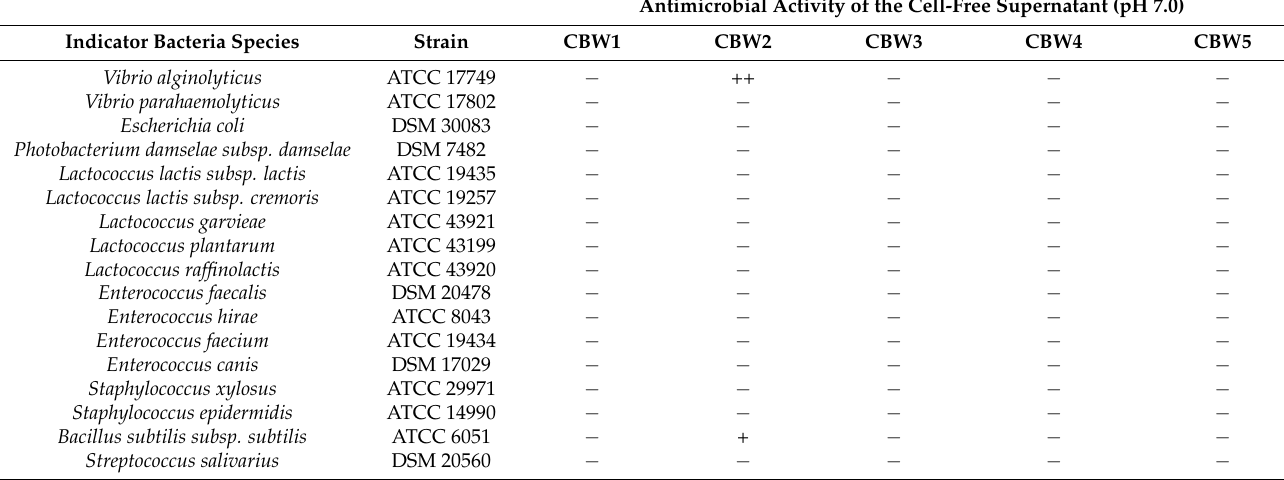
Table 2. Bacterial strains used for agar well diffusion assay and their sensitivity to the cell-free supernatant (pH 7.0) of five Lactococcus lactis subsp. lactis strains isolated from the fecal sample of a stranded female Cuvier’s beaked whale a .